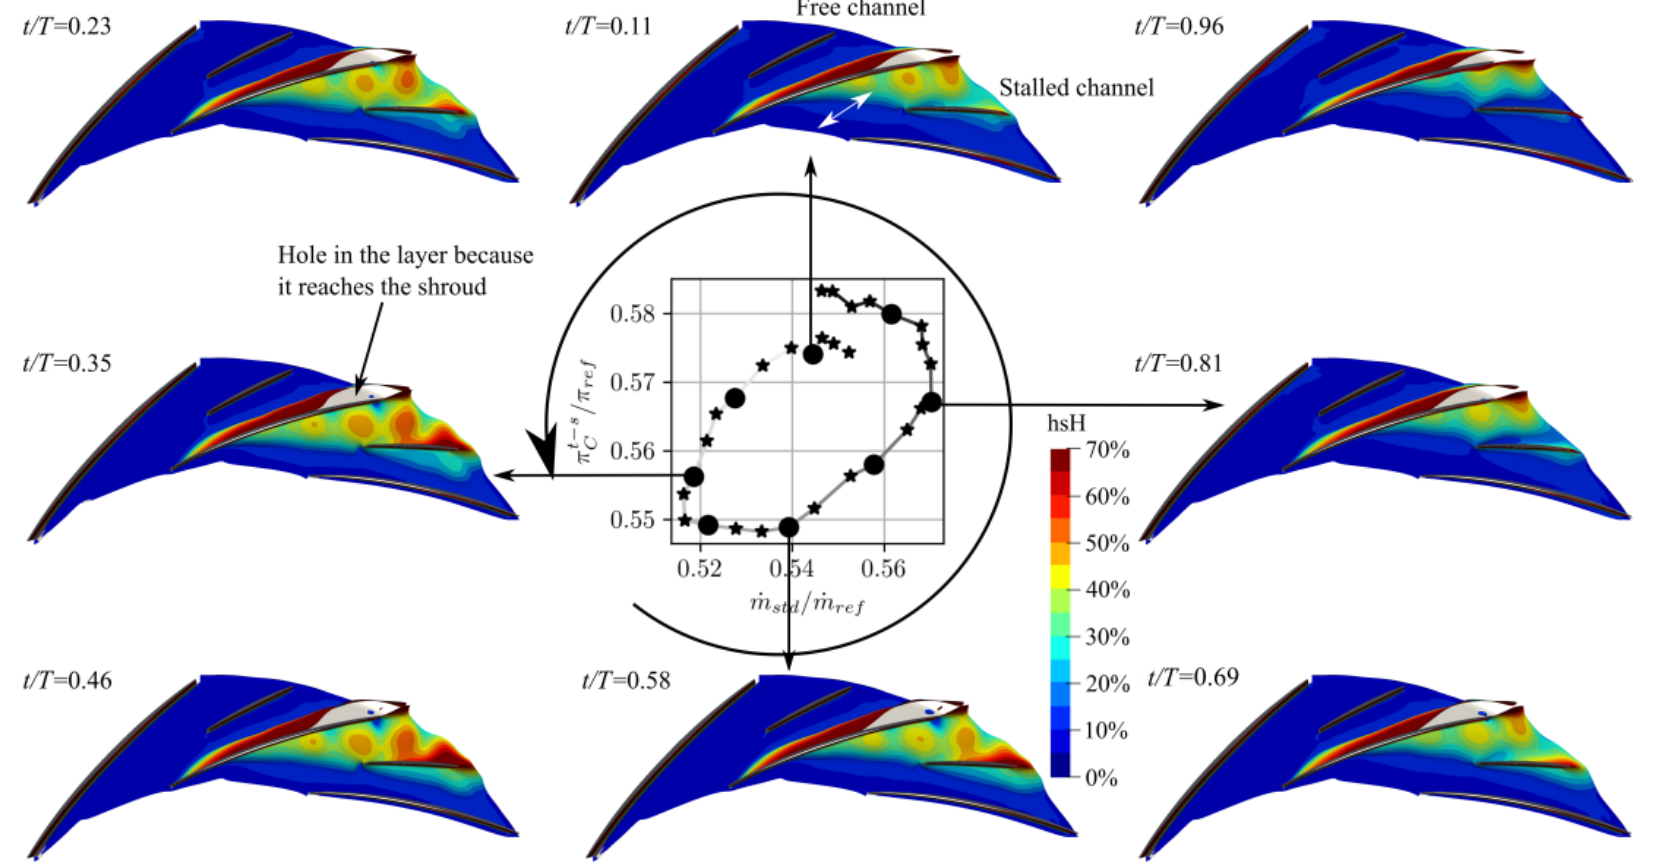
Figure 16. Change in the isosurface M abs = 0.1 colored by the span height during an alternate stall period at